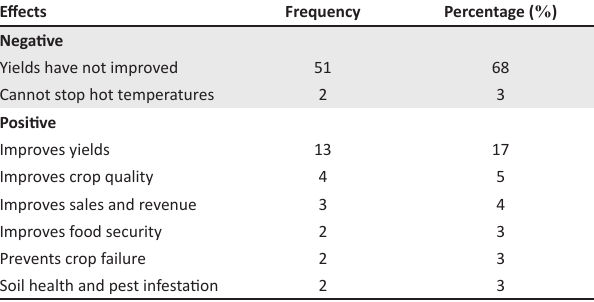
TABLE 4: Effectiveness of coping strategies on crop productivity.